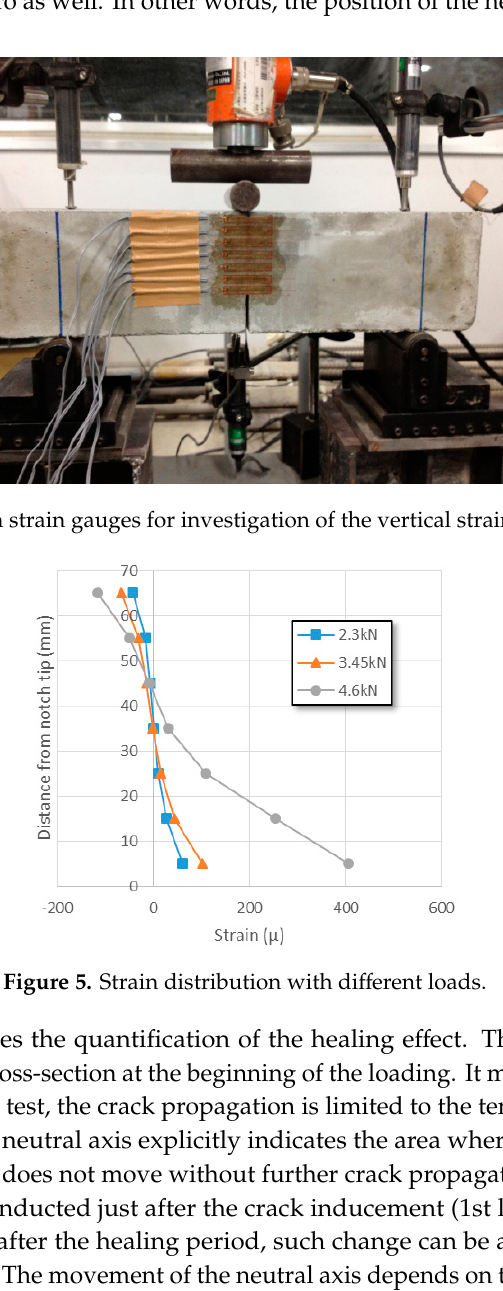
Figure 5. Strain distribution with different loads.